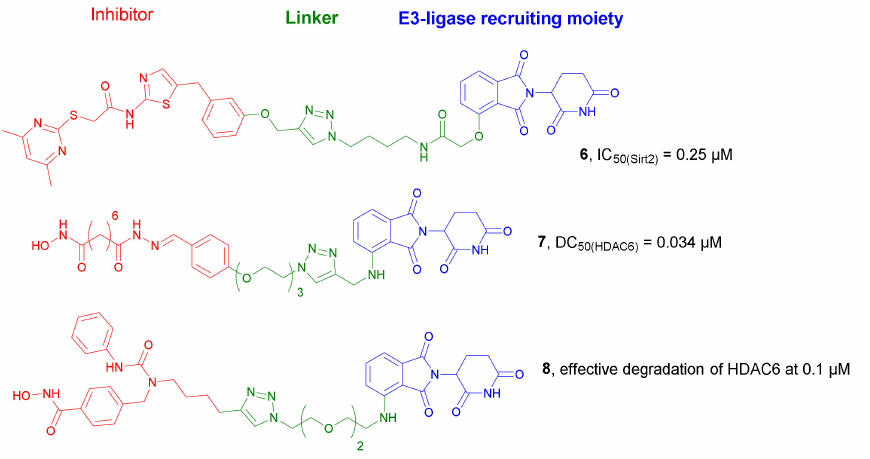
Figure 5. General structures of PROTACs 6 – 8